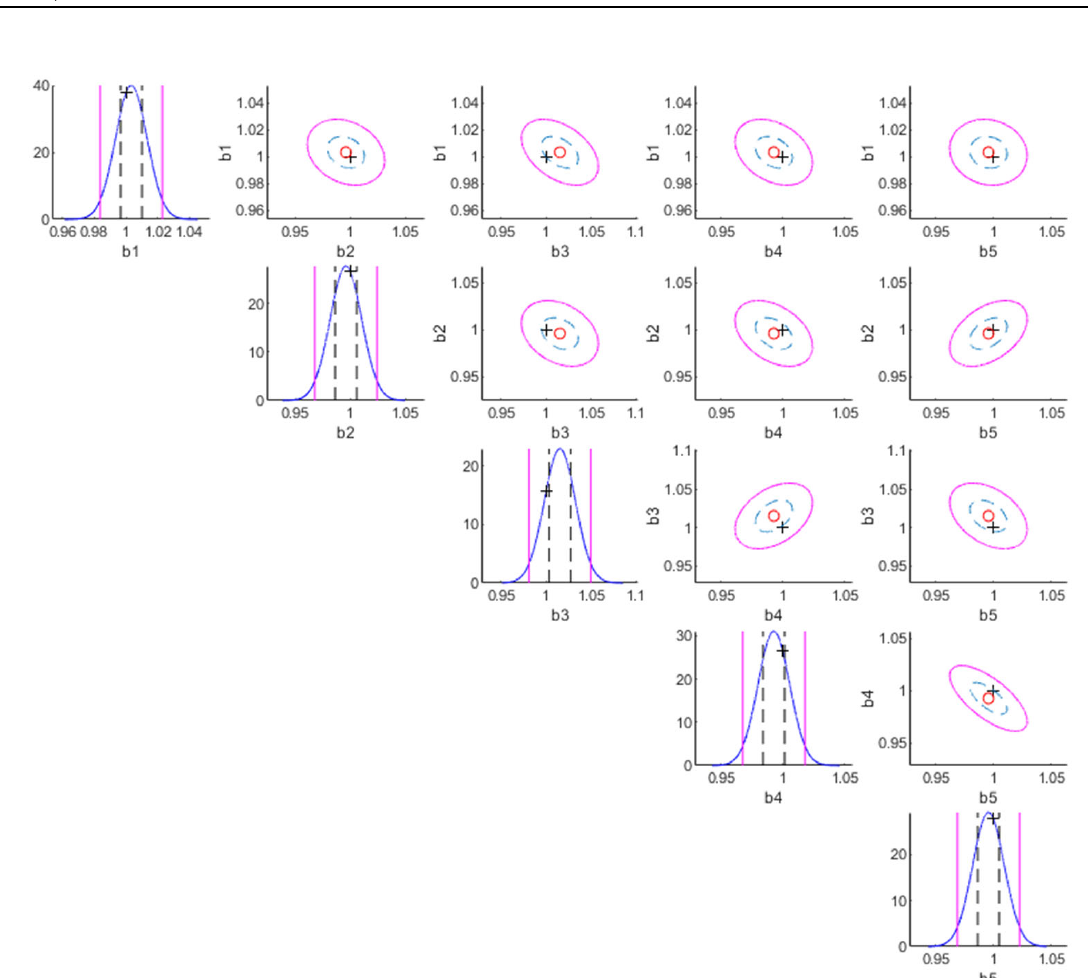
Figure 1. Contour plot of the posterior PDF of the substructure parameters of the most plausible model class (no damage case).